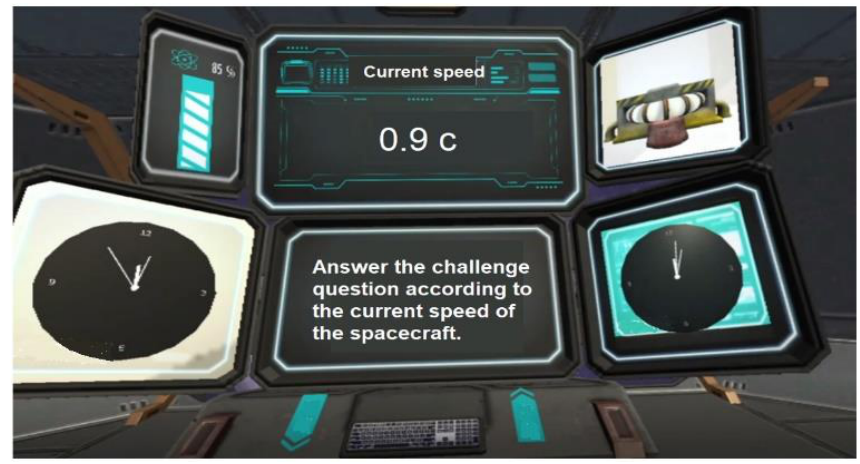
Figure 9. Control panel in the spacecraft cockpit. Since the spacecraft travels at 0.9 times the speed of light, the distance between Earth and Proxima Centauri measured by the pilot in the spacecraft is calculated as (cid:112) (cid:112) L = L 0 1 − v 2 / c 2 = 4.3 1 − 0.9 2 = 1.87 ( light year ) √ and the time elapsed in the spacecraft is only 60 1 − 0.9 2 = 26.15 (seconds). The learner can also see the planet deforming as the speed of spacecraft increases (Figure 10).